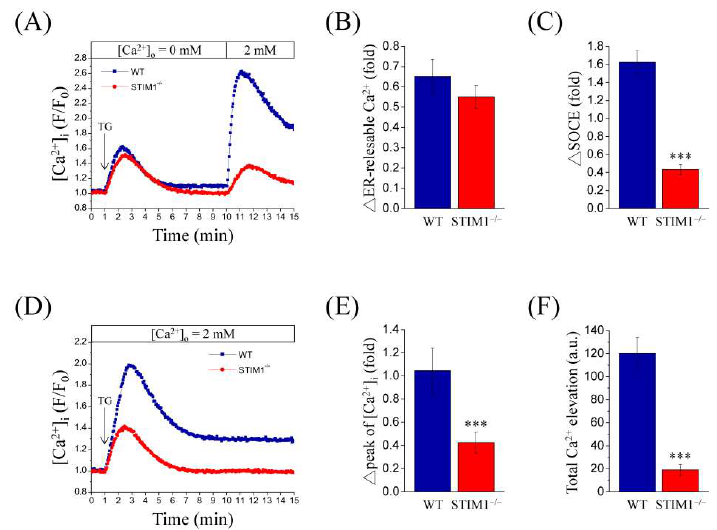
Figure 1. Thapsigargin (TG)-mediated store-operated Ca 2+ entry (SOCE) is suppressed in mouse embryonic fibroblast-STIM1 knockout (MEF-STIM1 −/− ) cells. ( A , D ) Representative tracings show the effect of 2 μM TG (arrow) on Fura-2/AM loaded MEF-WT (wild-type) and MEF-STIM1 −/− cells ( A ) in absence of extracellular Ca 2+ followed by addition of 2 mM Ca 2+ to the extracellular buffer or ( D ) at 2 mM extracellular Ca 2+ . Intracellular Ca 2+ ([Ca 2+ ] i ) was monitored using a single-cell fluorimeter for 15 min. Each trace represents the mean of at least four independent experiments. The bar charts show ( B ) ER Ca 2+ release, ( C ) SOCE, ( E ) initial Ca 2+ peak (change of peak value), and ( F ) total Ca 2+ elevation (area under the curve) following the addition of TG. Bars represent mean ± SEM. *** p < 0.001 by Student’s t -test. TG, thapsigargin; a.u., arbitrary unit.